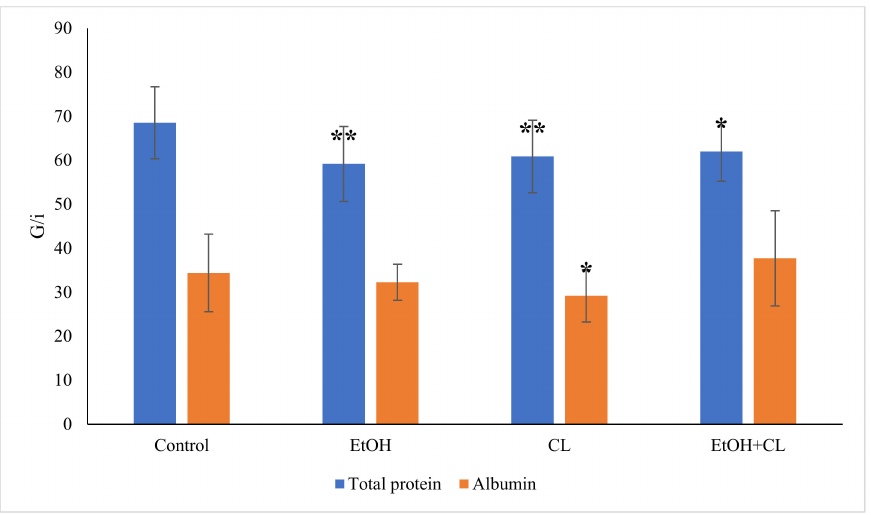
Figure 8. Total protein and albumin content in the blood plasma of rats, * p < 0.05, ** p < 0.01.